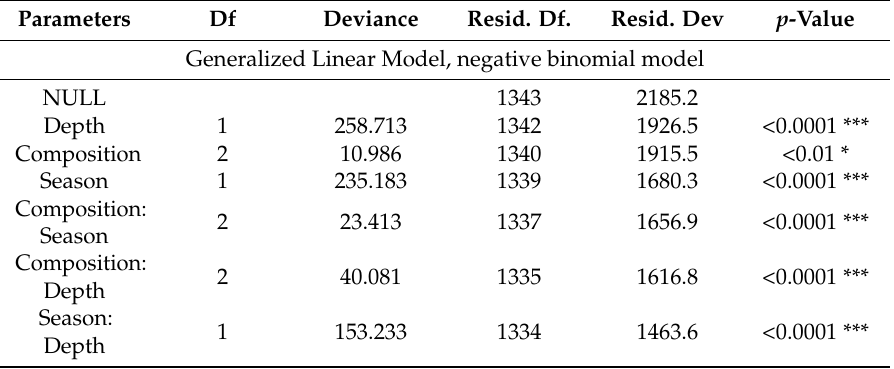
Table 4. Deviance table for the negative binomial model for the response status of vegetation cover. Resid.DF are the residual degrees of freedom and Resid.dev is the residual deviance. Significance of